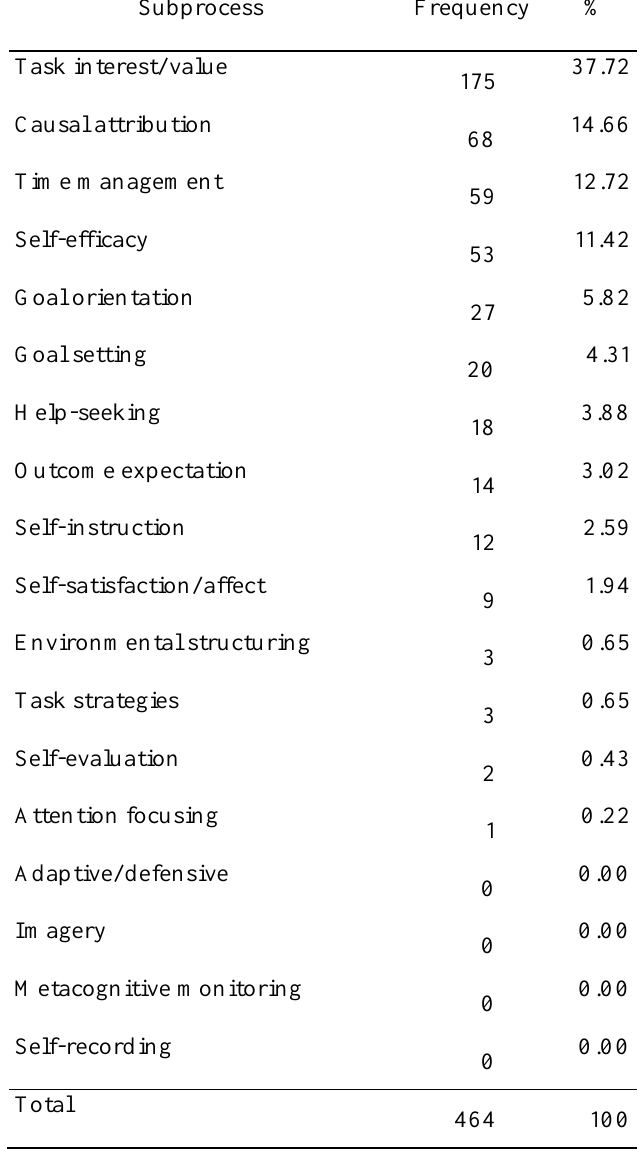
The Frequency of SRL Codes for MOOC